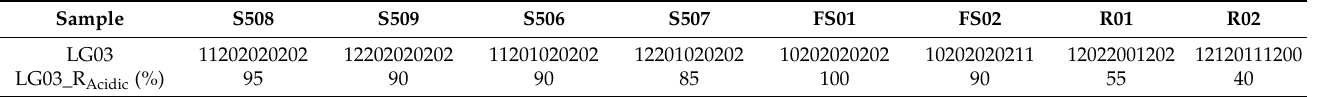
Table 3. Gene similarities of 8 samples with different sampling